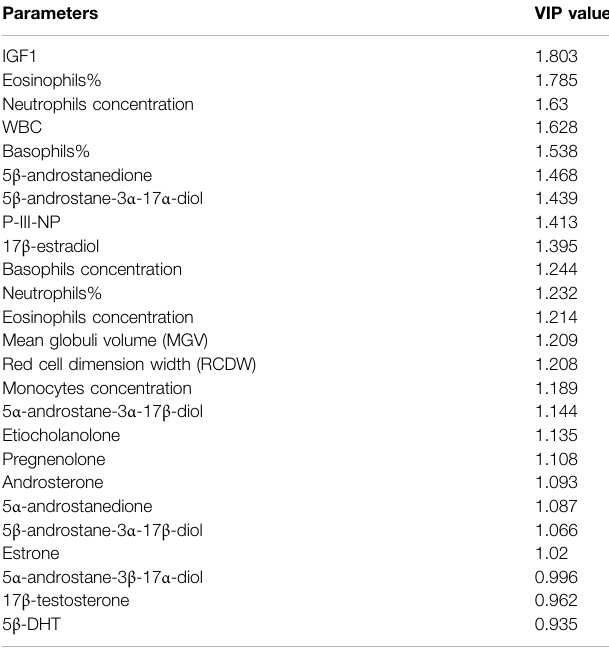
TABLE 3 | The putative biomarkers of rhGH administration with the relative Variable Important in Projection (VIP) value.